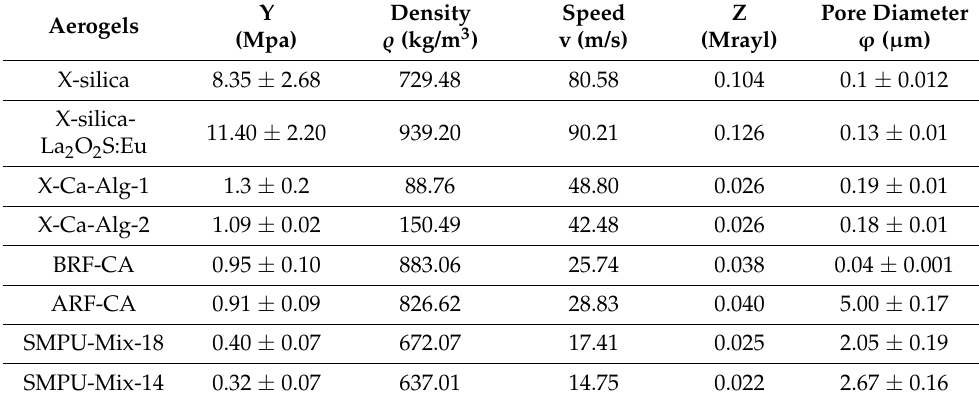
Table 4. Aerogel properties of each type used in this study: Young’s modulus (Y), Density ( (cid:36) ), Speed (v), Acoustic Impedance (Z), and Pore Diameter ( ϕ ). Y Density Speed Z Pore Diameter Aerogels ϕ ( µ m) (Mpa) v (m/s) (Mrayl) (cid:36) (kg/m 3 ) X-silica 8.35 ± 2.68 729.48 80.58 0.104 0.1 ± 0.012 X-silica- 11.40 ± 2.20 939.20 0.13 ± 0.01 La 2 O 2 S:Eu X-Ca-Alg-1 0.18 ± 0.01 BRF-CA 0.95 ± 0.10 883.06 25.74 0.04 ± 0.001